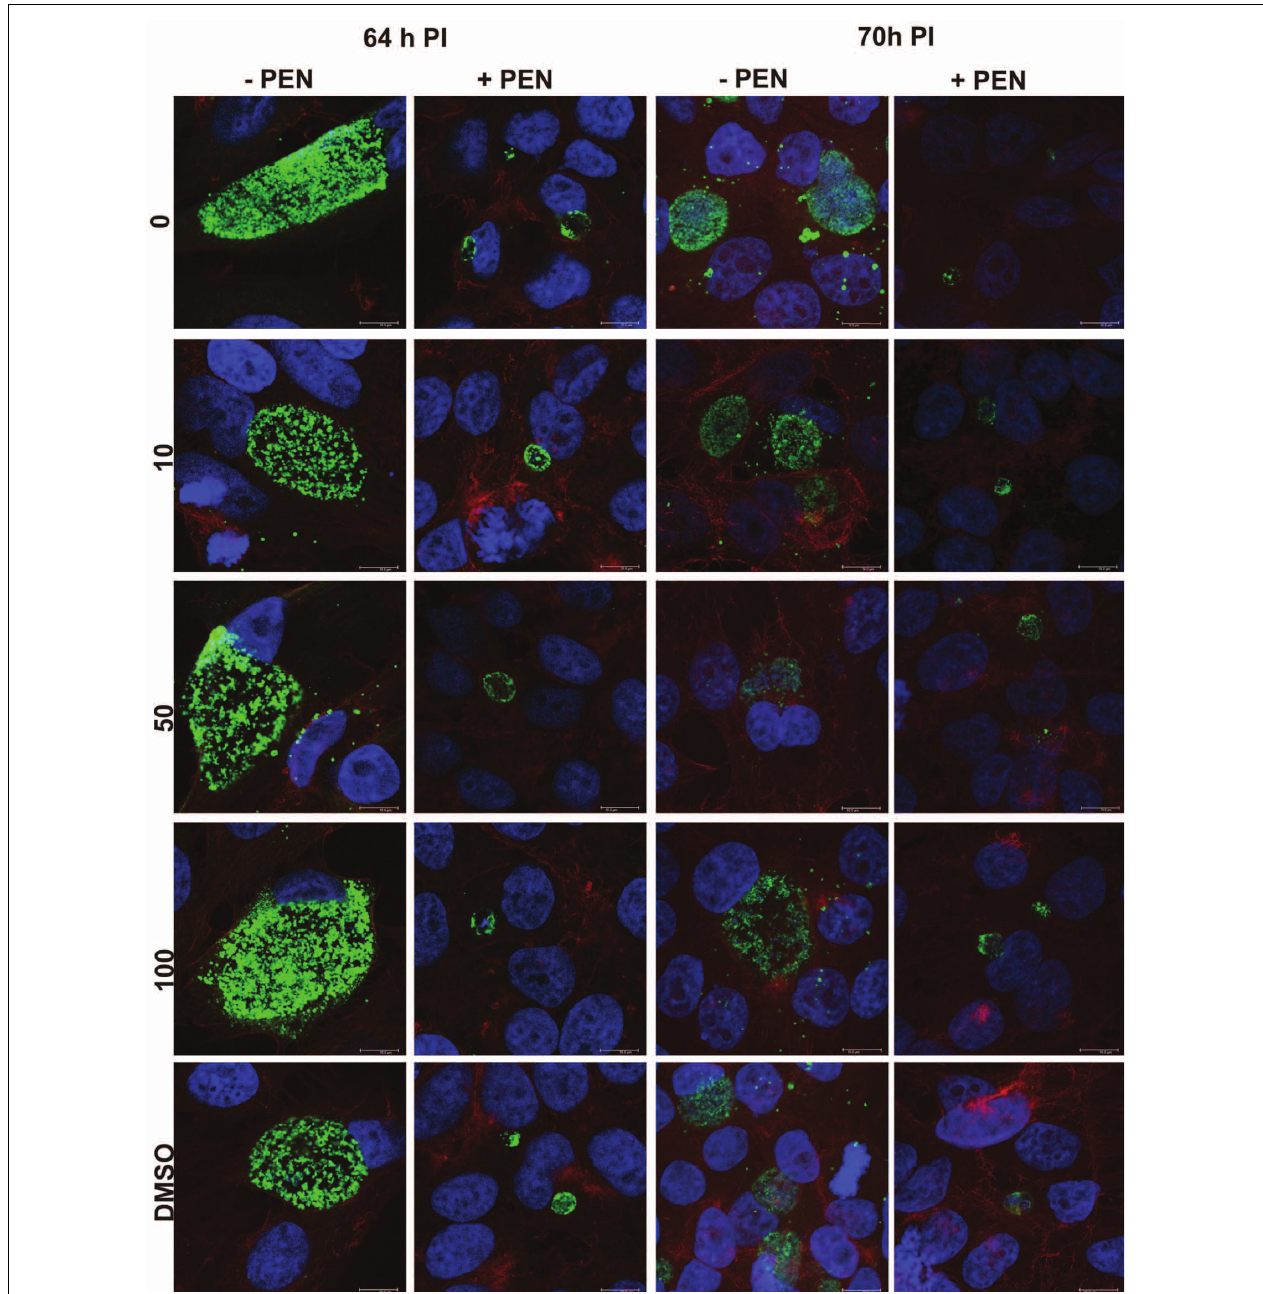
FIGURE 8 | Confocal microscopy images of penicillin persistent cultures and controls during reversion from persistence at 64 and 70hPI. Cultures were treated with penicillin 100U ml − 1 at 4h PI. Penicillin was removed at 40h PI and JO146 treatment was commenced at 52h PI. Controls with no